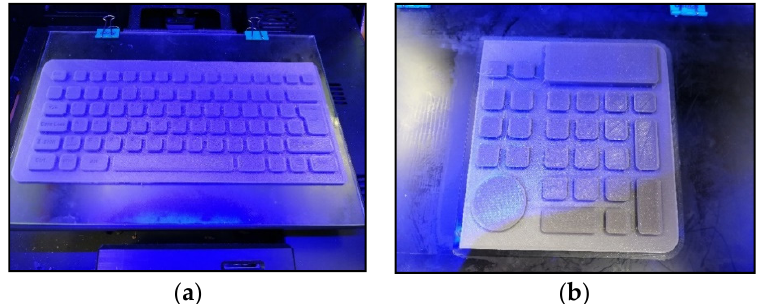
Figure 8. Images of the 3D printing process: ( a ) printing of the main body; ( b ) printing of the numeric keypad.